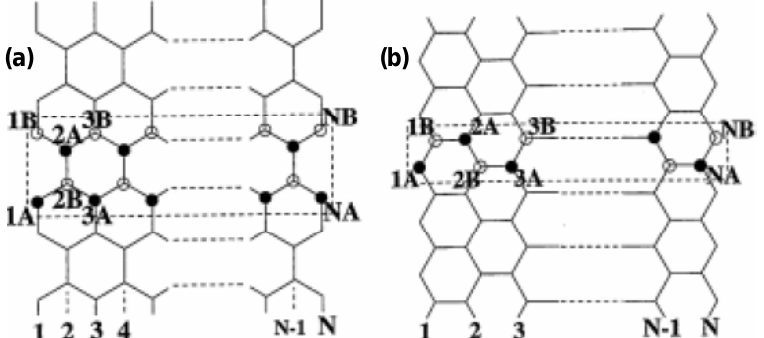
Fig. 2. The structure of the terminal atoms in the graphene nanoribbons: (a) chair and (b) zig-zag, adapted from [52].